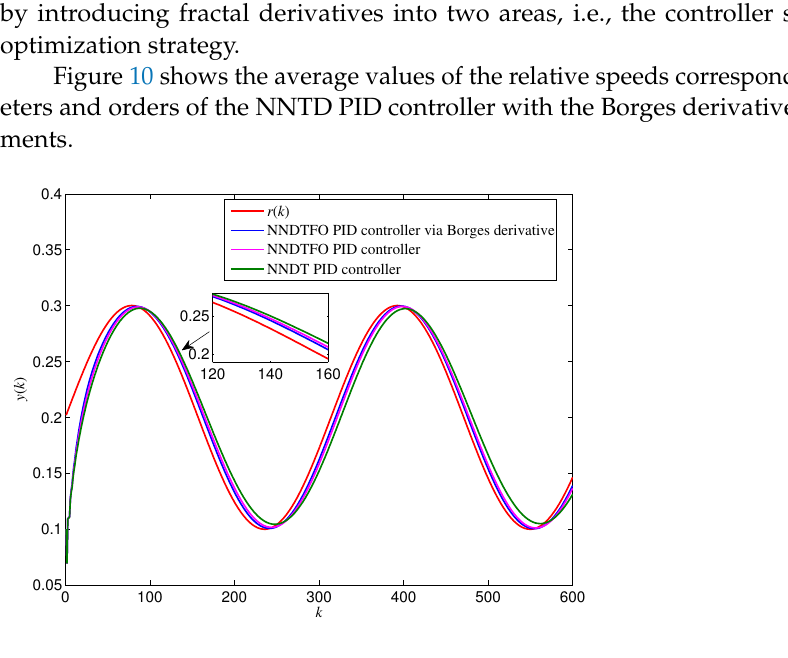
Figure 9. Responses of outputs y ( k ) via three types of PID controller of a closed loop system for example 2 with a sinusoidal